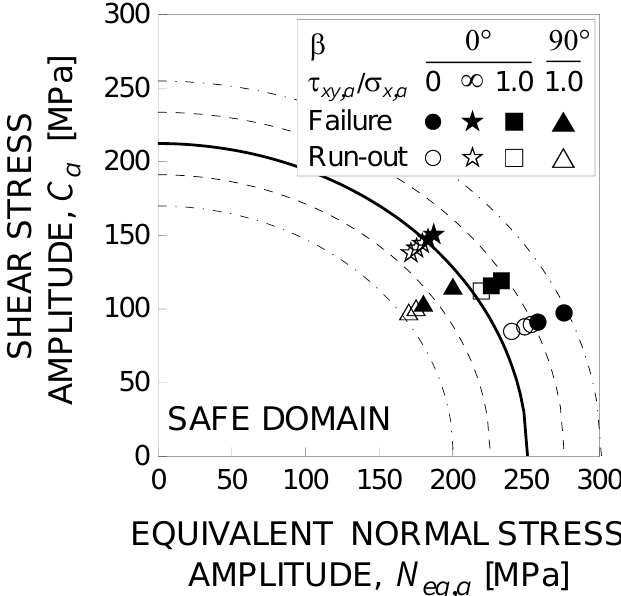
Figure 5. Shear stress amplitude vs. equivalent normal stress amplitude acting on the critical plane for EN-GJS-700-2 DCI.